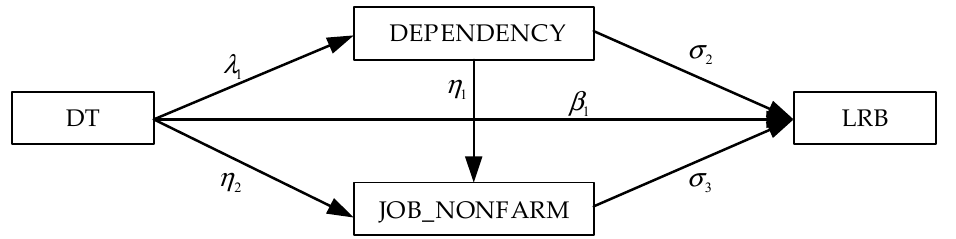
Figure 2. Schematic diagram of the CMM model.